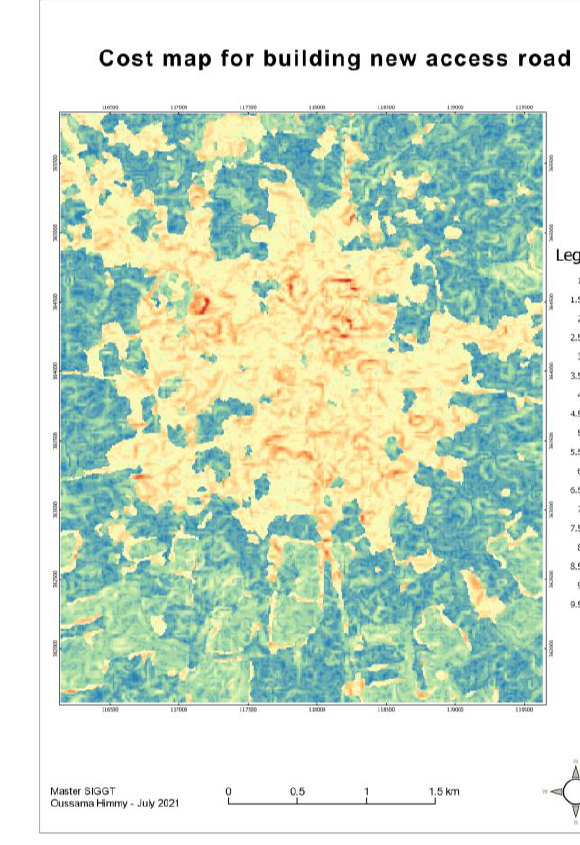
Figure 11 . Cost map for building new access road